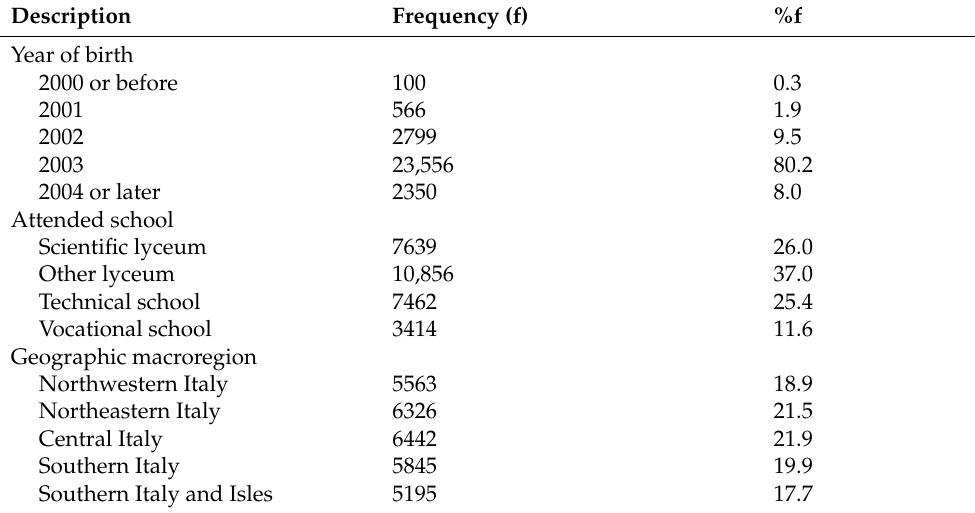
Table 1. The description of the